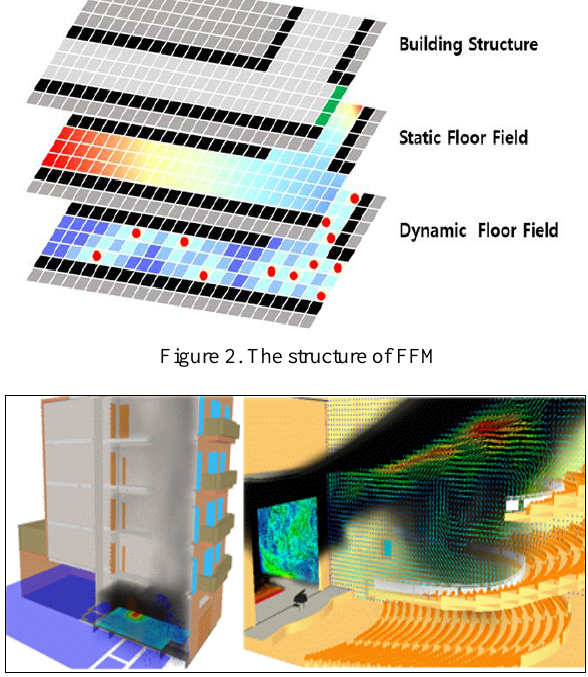
Figure 3. Simulation of